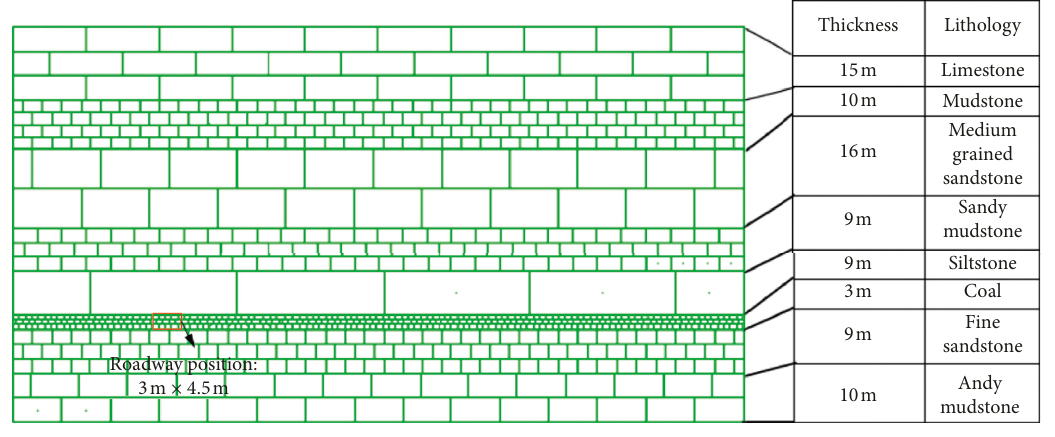
Figure 7: Numerical model.